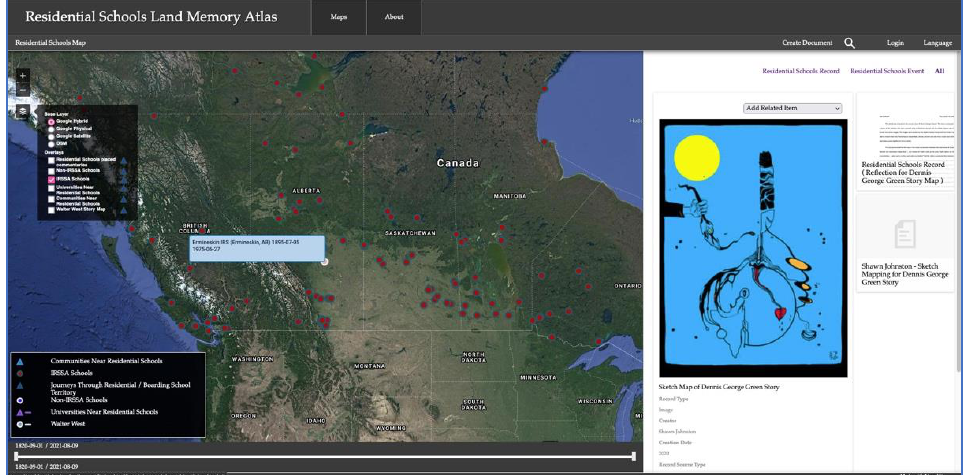
Figure 8. Screenshot of the Residential Schools Map of the Residential Schools Land Memory Atlas, showing document view and thumbnails of the sketch mapping by Shawn Johnston in the side panel and the location for the Ermineskin Residential School in the center map panel (Available online: https://residentialschoolsatlas.org/index.html?module=module.residential_schools#eyJ0 IjoieCIsImkiOiIxMzE4NGNkZTdjODViZGZkODA5MzdmZDkzZjVhNTM4OCIsInMiOjE2NDQ4 NjUwMzE0MDN9, (accessed on 1 April